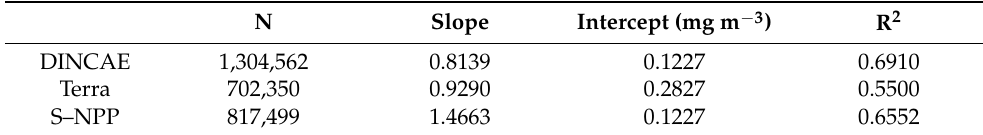
Table 2. Linear regression results for Aqua test data with three data